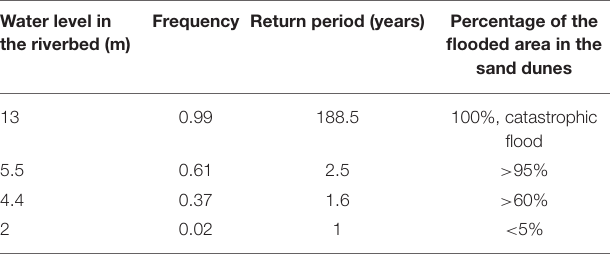
TABLE 2 | Frequency analysis and percentage of the sand river’s flooded areas for certain water levels. Water level in Frequency Return period the riverbed (m)